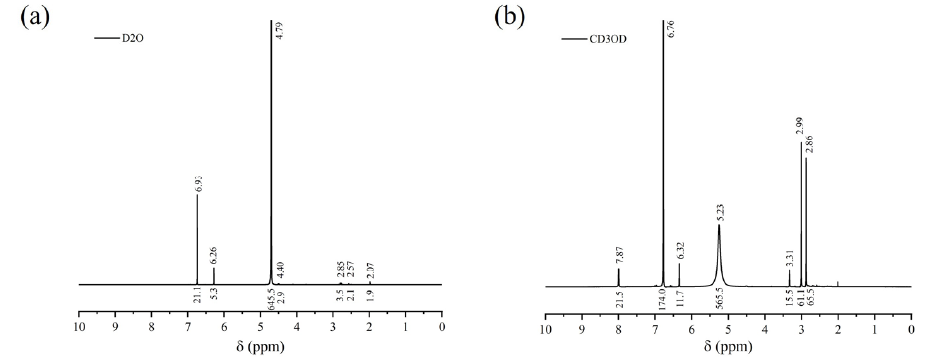
Figure 3. 1 H-NMR spectrum of FAS: ( a ) D2O; ( b ) CD3OD.